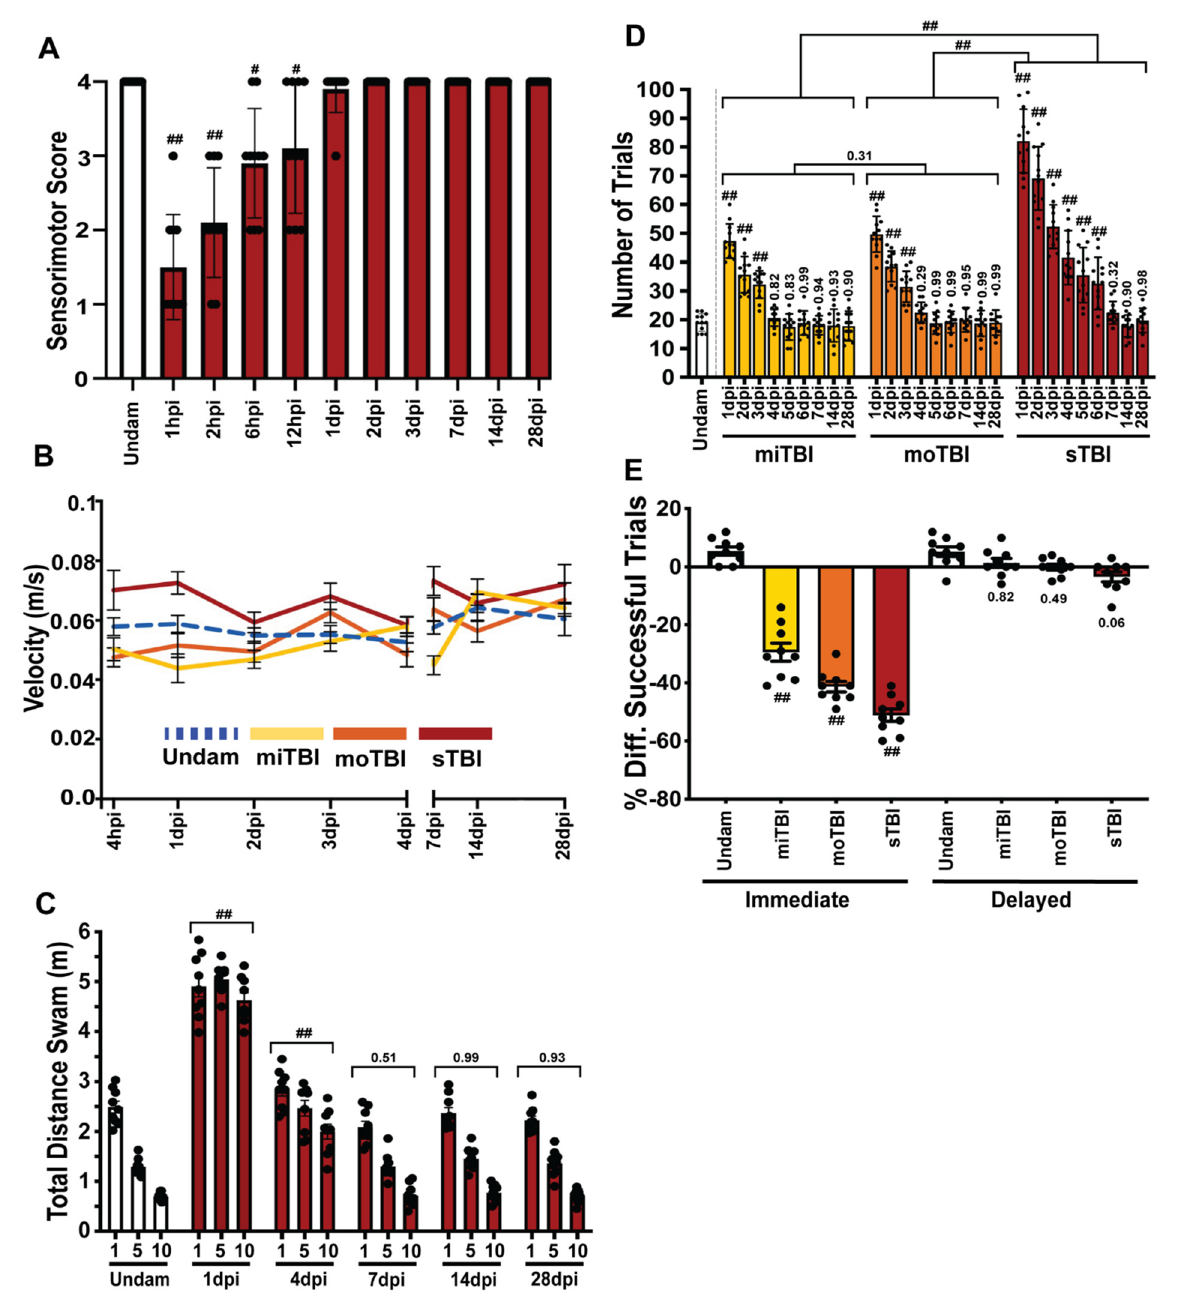
Figure 6. Injury-induced sensorimotor and cognitive deficits are severity-dependent with rapid recovery. ( A ) Sensorimotor coordination (plotted as a sum of four independent sensorimotor features involving swimming orientation and adverse tactile stimulus, Table 1) was significantly impaired following sTBI for up to 12 hpi compared to the pre-injury response (n = 10). ( B ) The unprovoked swim velocity over time was not significantly different between undamaged controls and all three severity models from 4 hpi to 28 dpi (n = 15). ( C ) Quantification of the swim distance of undamaged and sTBI fish following the startle response across iterations 1, 5, and 10 at 1, 4, and 7 dpi. TBI-damaged fish displayed cognitive